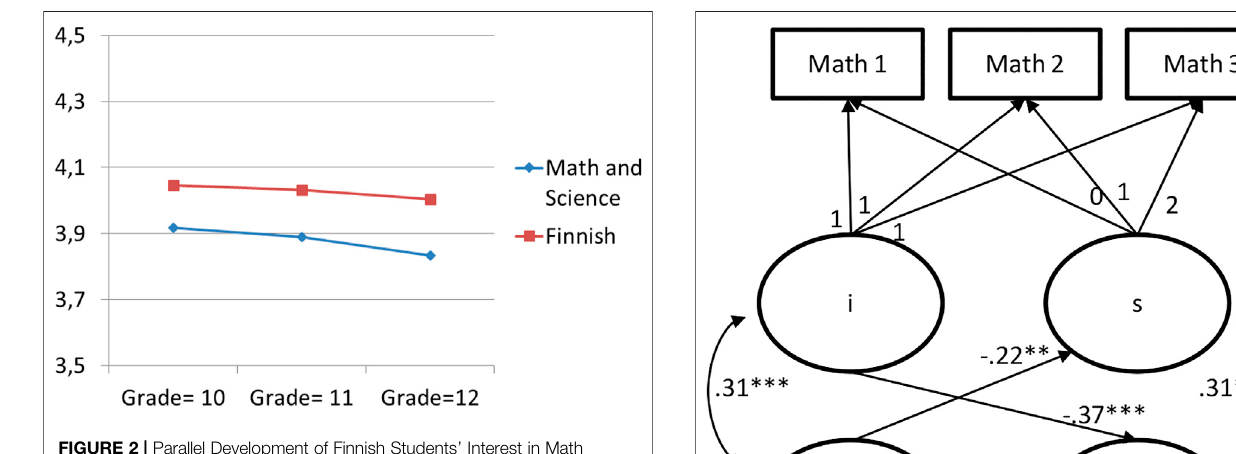
FIGURE 2 | Parallel Development of Finnish Students ’ Interest in Math and Science, and